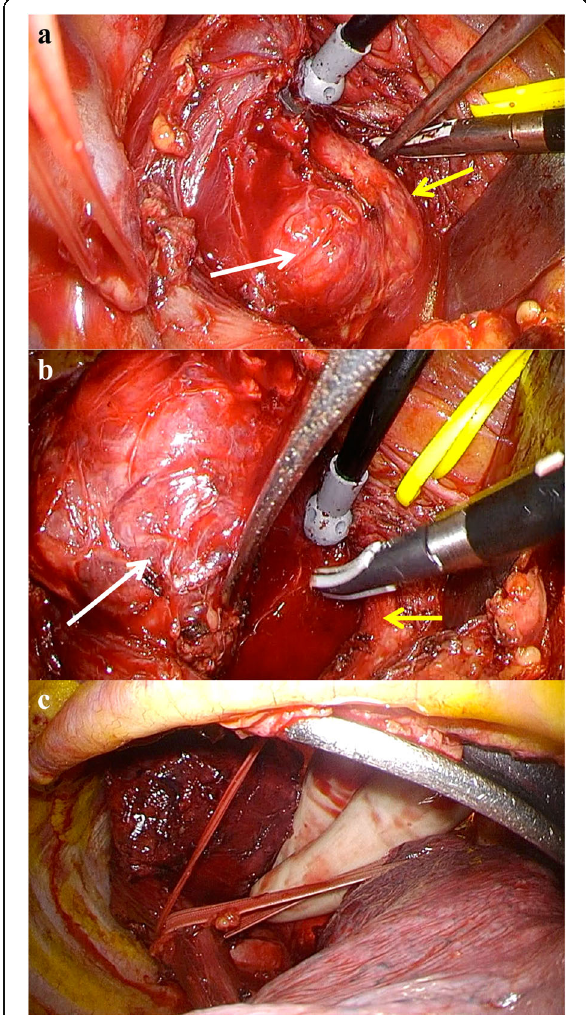
Fig. 4 Intraoperative findings ( a , b , c ). White arrows show the mediastinal tumor and yellow arrows show the trachea ( a , b